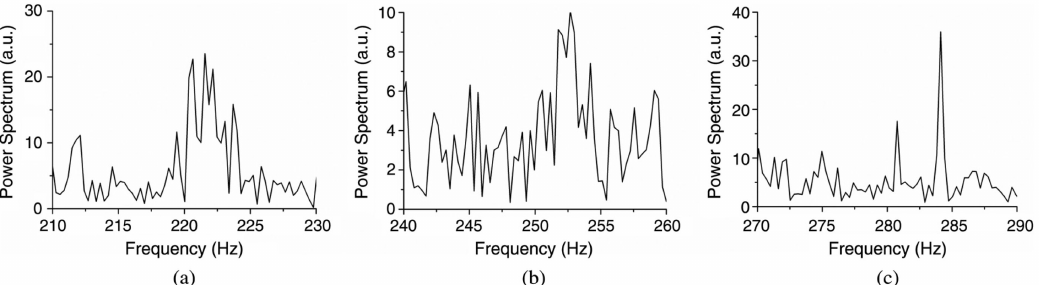
Figure 6. Beat spectrum when using a superposed vortex beam for illumination with different topological charges. ( a ) l = ± 7, ( b ) l = ± 8, and ( c ) l = ± 9. Adapted with permission from ref. [33].